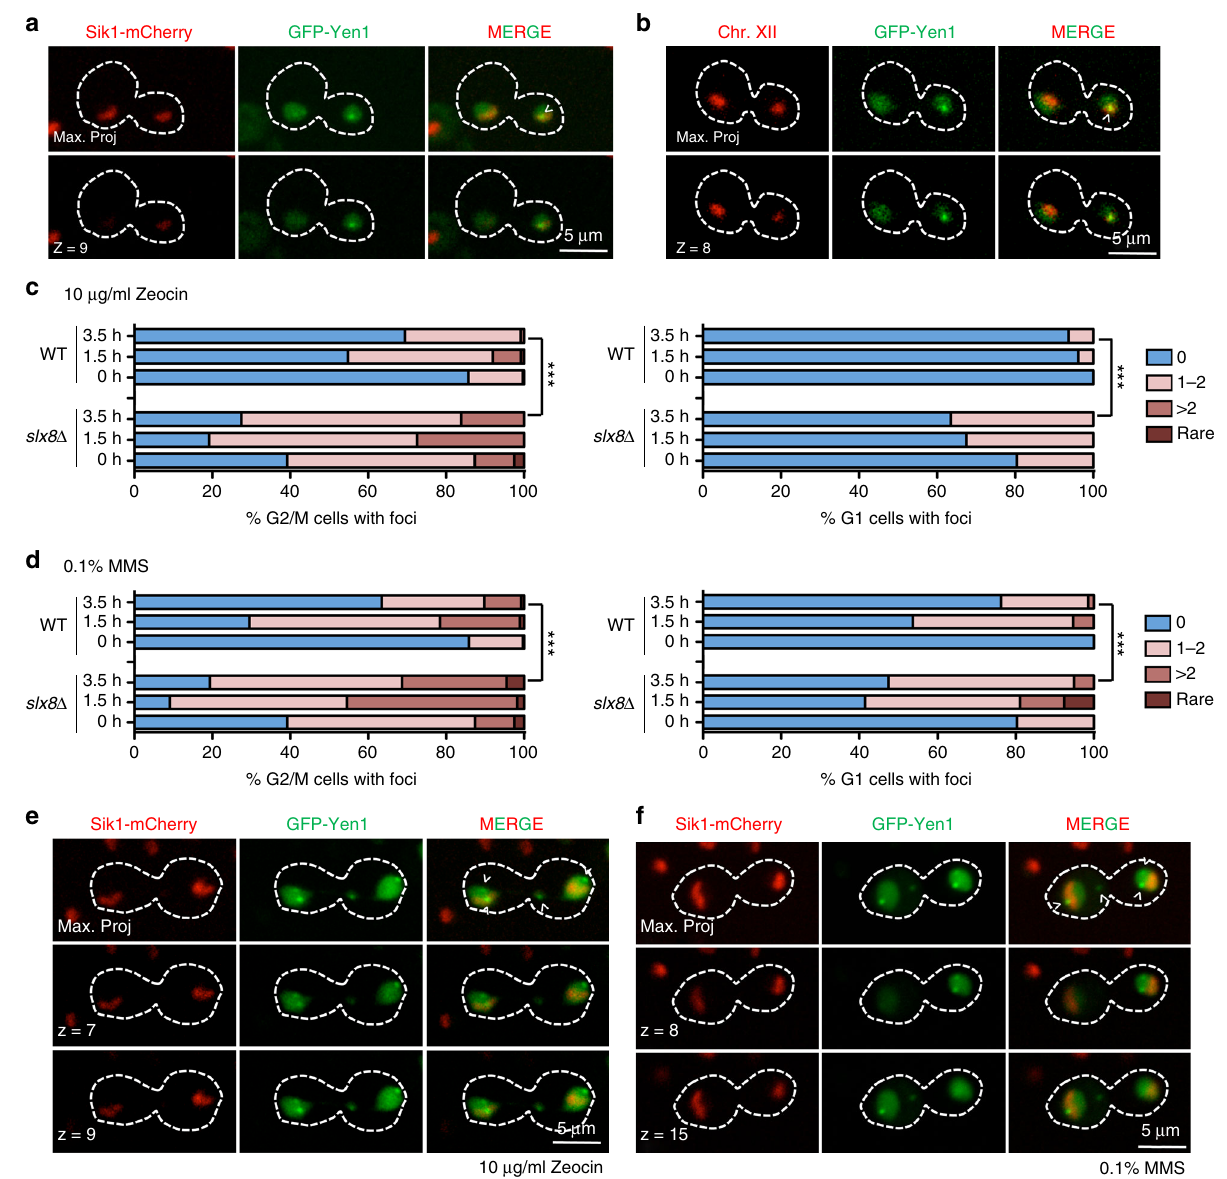
Fig. 5 Yen1 foci are dynamic and localize preferentially to nucleolar sites in the absence of DNA damage. a slx8 Δ cells carrying a SIK1 -mCherry endogenous marker and an inducible GFP-Yen1 expressing plasmid were observed after short induction of the fusion protein. The white arrow denotes co-localizing signal of GFP-Yen1 with Sik1-mCherry. b Wild-type cells carrying a TetO-TetR array tag on chromosome XII and an inducible GFP-Yen1 expressing plasmid were observed after short induction of the fusion protein. c Cells were subjected to acute challenge with Zeocin (0.01mg/ml) and observed during their recovery as in Fig. 4. Cells displaying the designated categories of GFP-Yen1 foci were scored at the indicated time points. The total number of cells analysed ( n ) from two independent recordings were as follows: WT 0 h ( n G1 = 81, n G2/M = 267), WT 1.5 h ( n G1 = 78, n G2/M = 124), WT 3.5 h ( n G1 = 110, n = 118), slx8 Δ 0 h ( n = 107, n = 79), slx8 Δ 1.5 h ( n = 40, n = 73), slx8 Δ 3.5 h ( n = 52, n = 62). d Cells were subjected to an acute G2/M G1 G2/M G1 G2/M G1 G2/M challenge with 0.1% MMS and for foci were observed as in c . The total number of cells analysed ( n ) from two independent recordings were as follows: WT